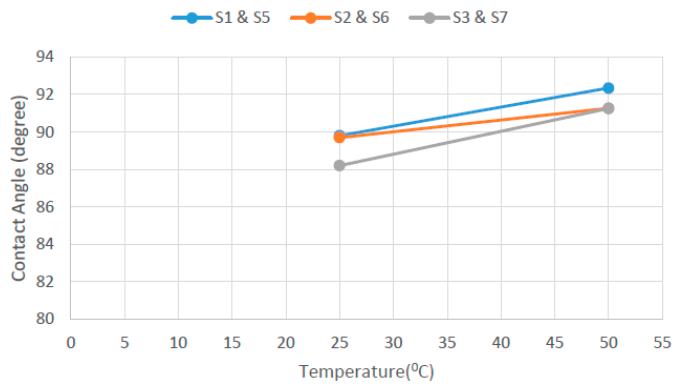
Figure 5. Contact angle variation in eight samples with increase in temperature for brine B2. Energies 2017 , 10 , 322